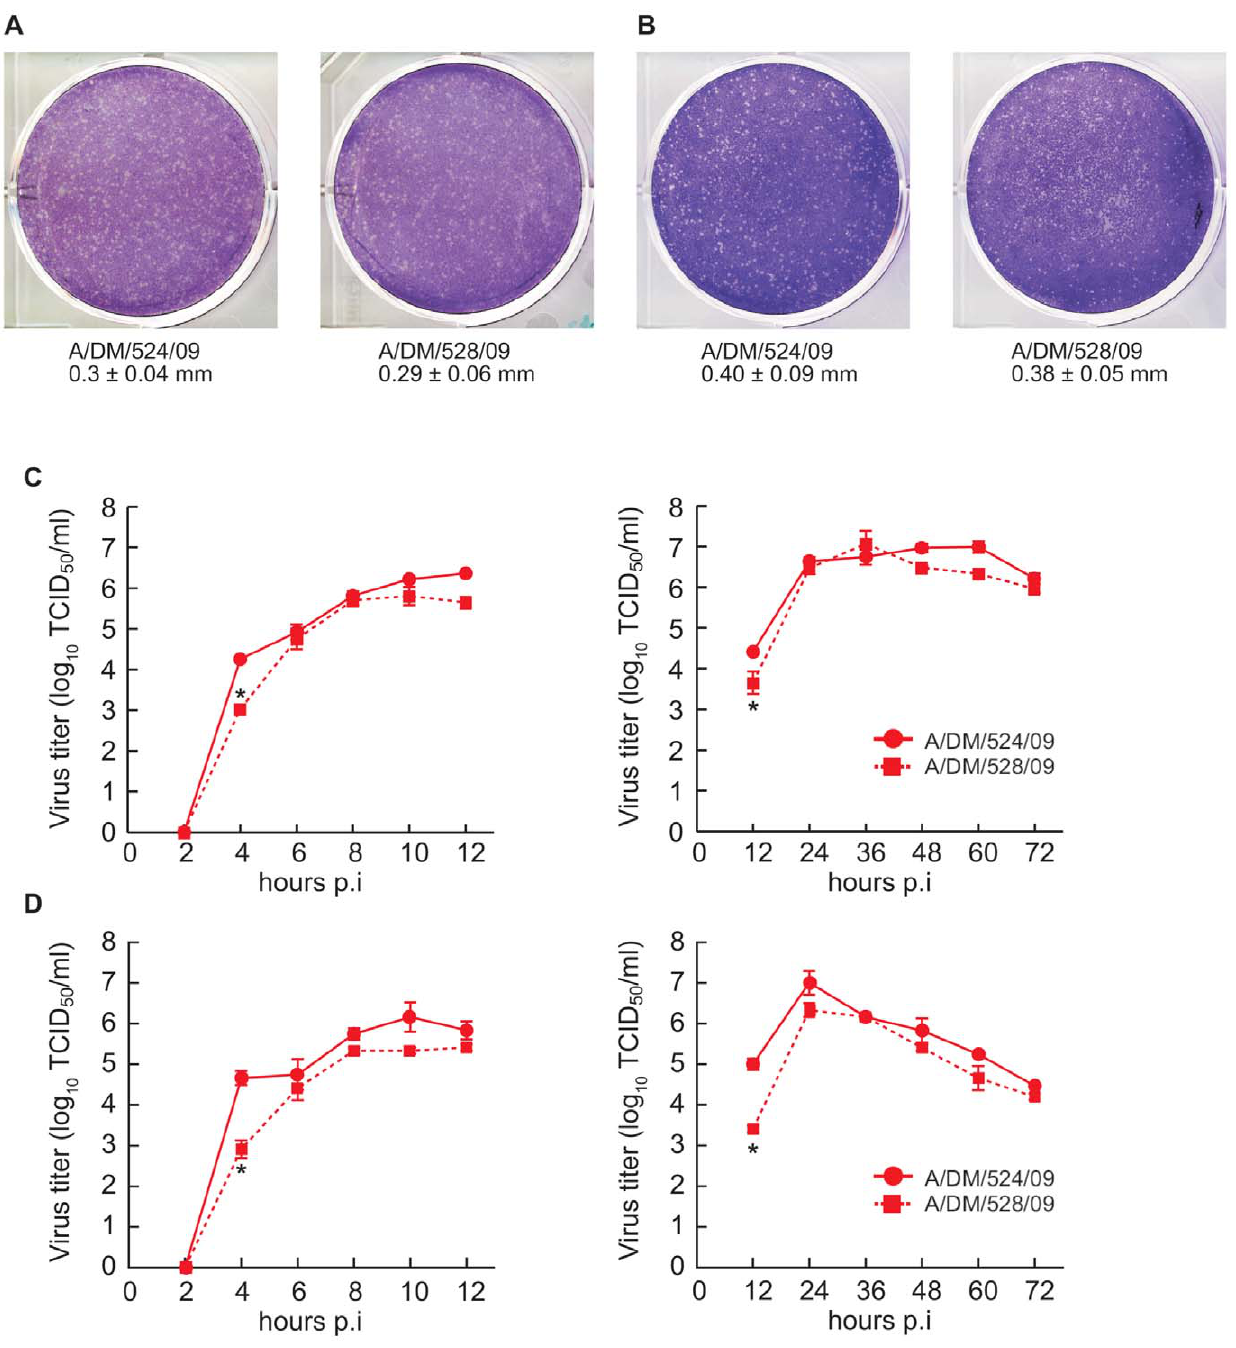
Figure 1. Plaque morphology and replication kinetics of two H1N1/2009 influenza viruses in MDCK and MDCK-SIAT1 cells. The diameters of 20 randomly selected value plaques were measured in MDCK cells (A) and MDCK-SIAT1 cells (B). Values are mean ( 6 SD) plaque diameter (mm). Single-cycle (C, D left panel) and multiple-cycle (C, D right panel) growth curves were obtained by using an MOI of , 2 and , 0.001 PFU/cell, respectively. Virus in the supernatant was titrated in MDCK or MDCK-SIAT1 cells and expressed as log 10 TCID 50 /ml at the indicated time post-infection. Each point represents the mean log 10 TCID 50 /ml 6 SD from three experiments. * P , 0.05 compared to value for wild-type viruses.